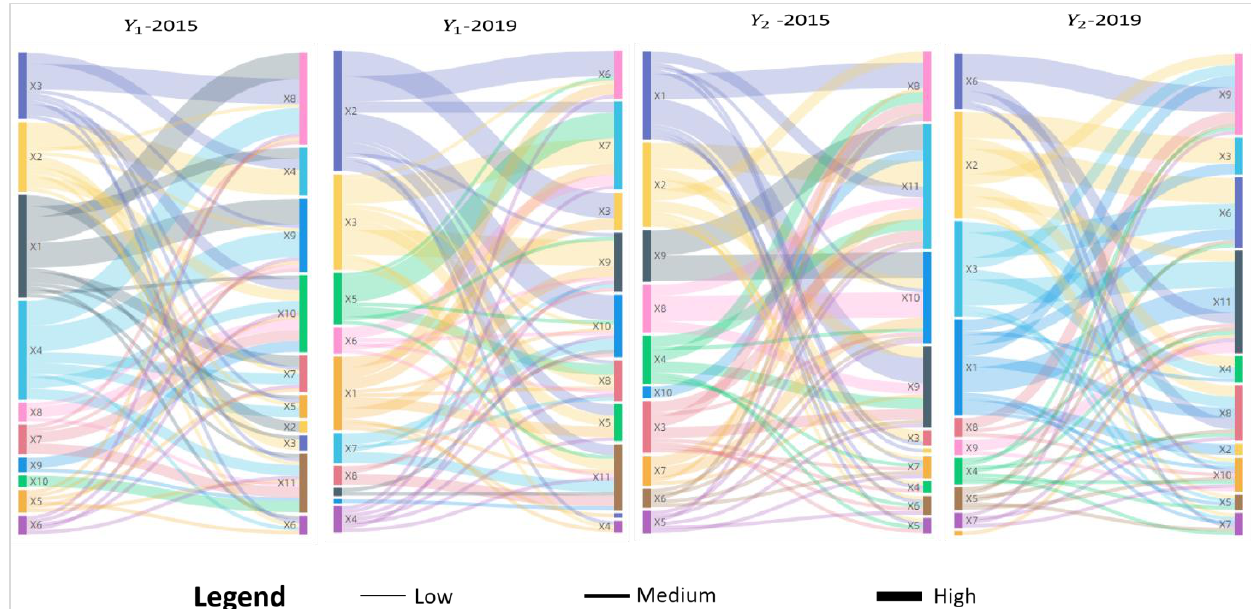
Figure 5. Interaction detector analysis of urban night lighting data in Guangxi.